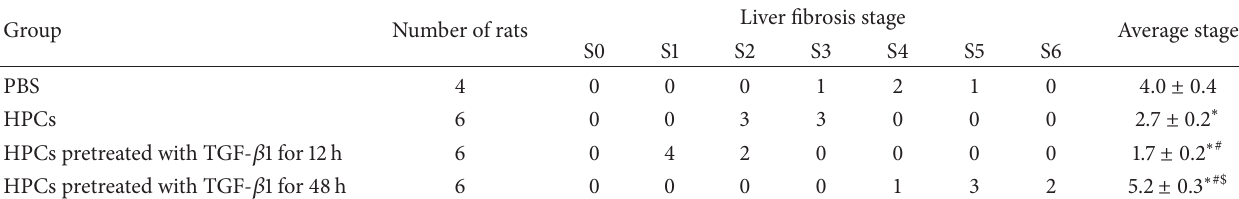
Table 1: Quantitative evaluation of liver fibrosis.